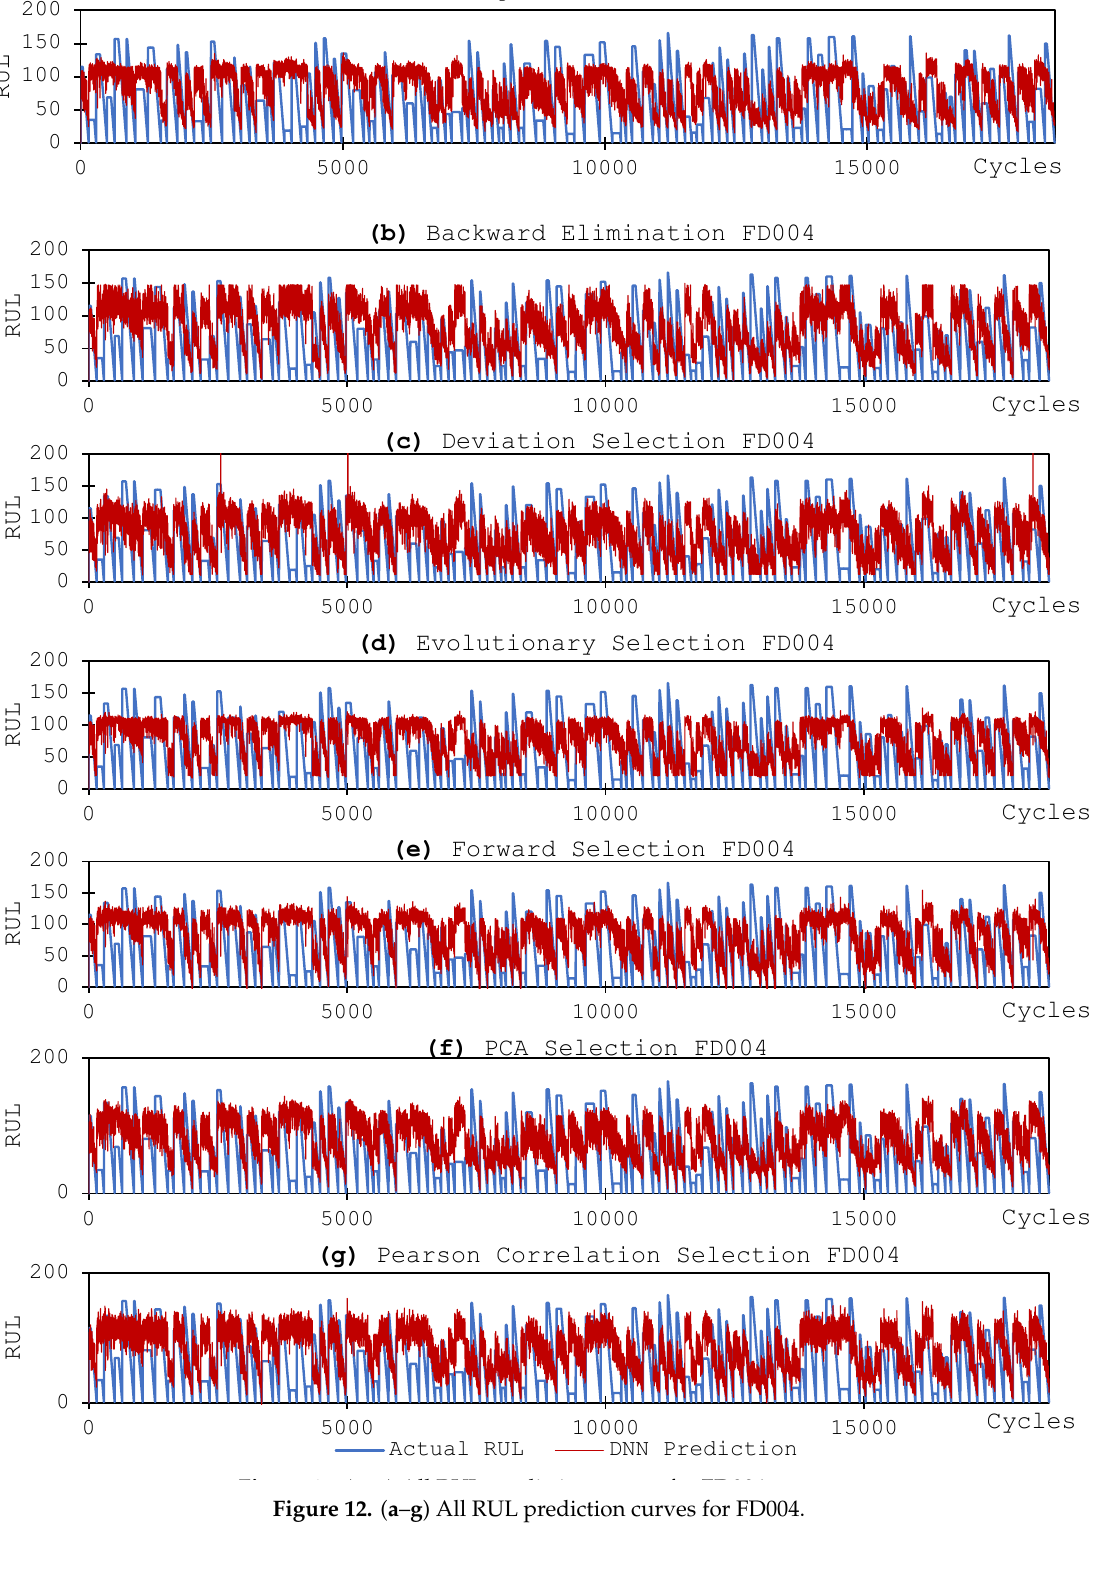
Figure 12. ( a – g ) All RUL prediction curves for FD004.